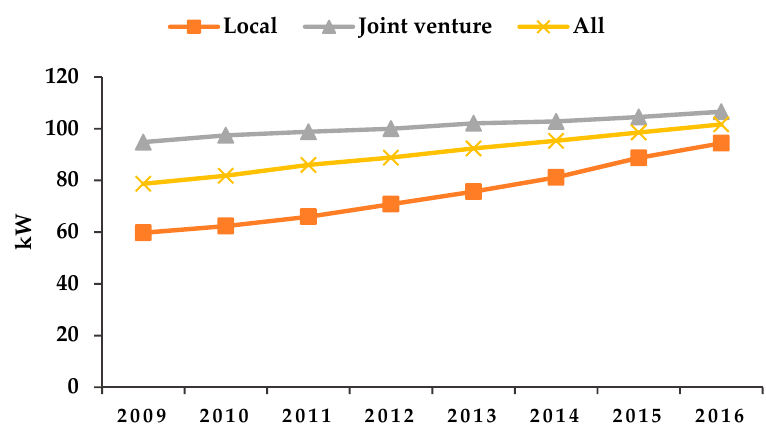
Figure 3. Production-weighted power of China’s domestic passenger vehicles in 2009–2016.